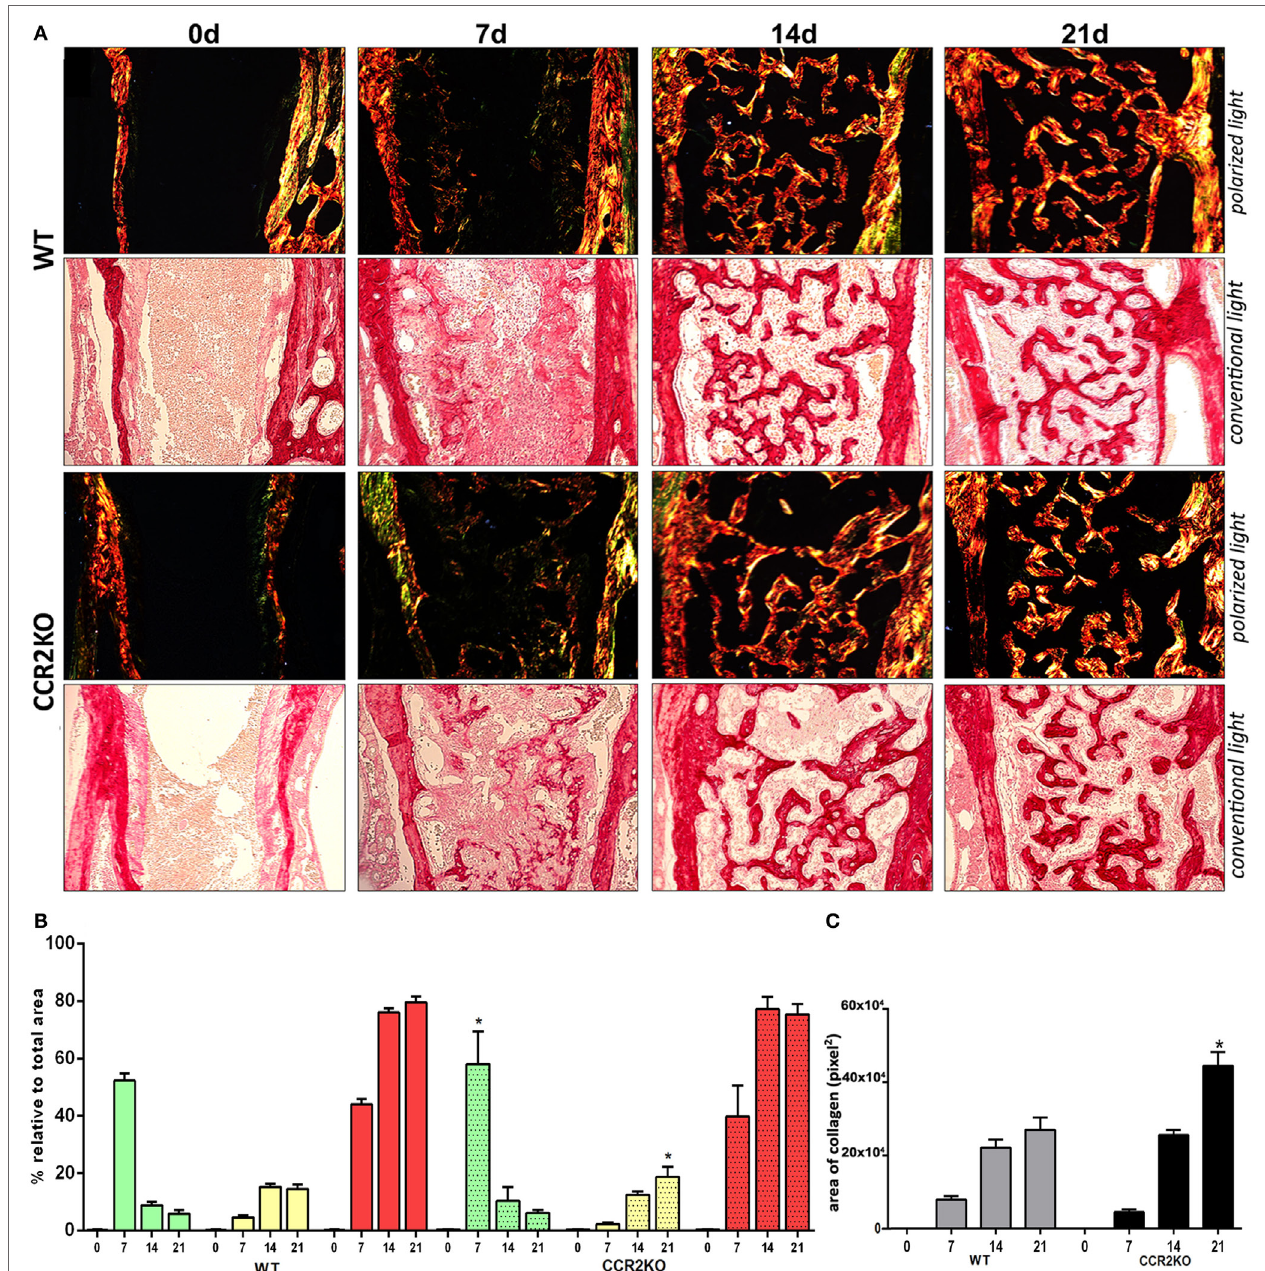
FigUre 4 | Birefringence analysis of collagen fiber bundles maturation along intramembranous bone healing in wild-type (WT) vs CCR2KO mice. (a) Representative sections from medial thirds of the socket stained with Picrosirius red upon polarized and conventional light at 0 h and 7, 14, and 21 days (20 × magnification). Green birefringence color indicates thin fibers, while yellow and red colors indicate thick collagen fibers. (B) Intensity of birefringence performed using image-analysis software (AxioVision, v. 4.8, CarlZeiss) from each color (%) to quantify thin and thick collagen fibers, as well (c) total area of collagen fibers (pixels 2 ) in WT vs CCR2KO mice. Results are presented as mean and SD of % (B) and pixels 2 (c) . Symbol * indicates a statistically significant difference ( p < 0.05) between WT vs CCR2KO at the same time